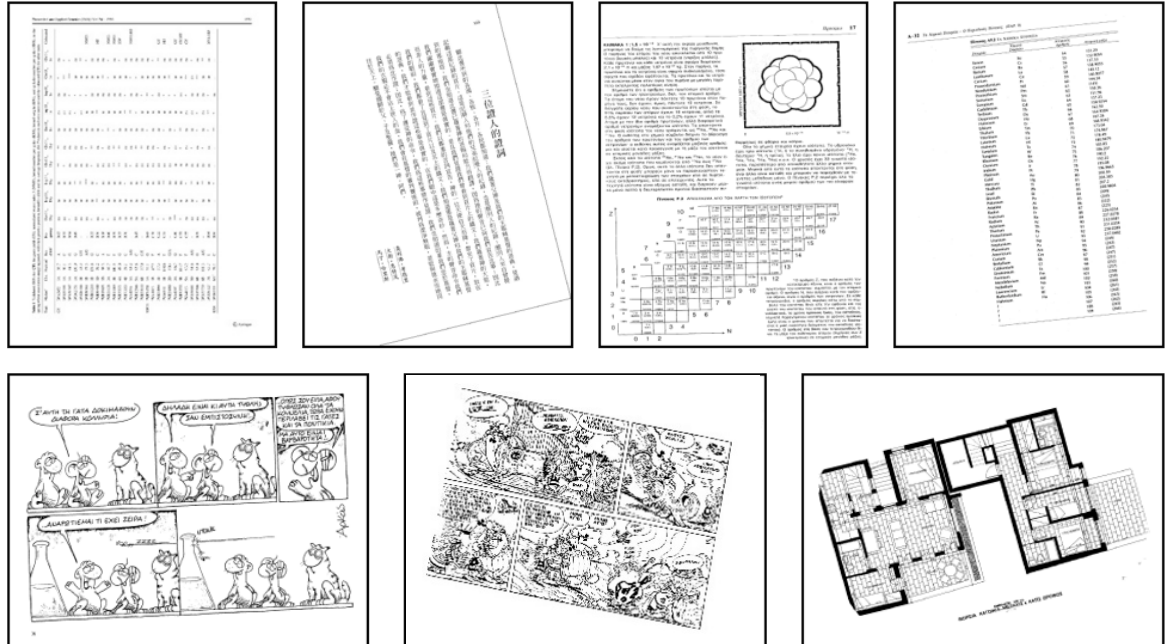
Figure 7. Test images from data set DISEC 2013 and PubLayNet.